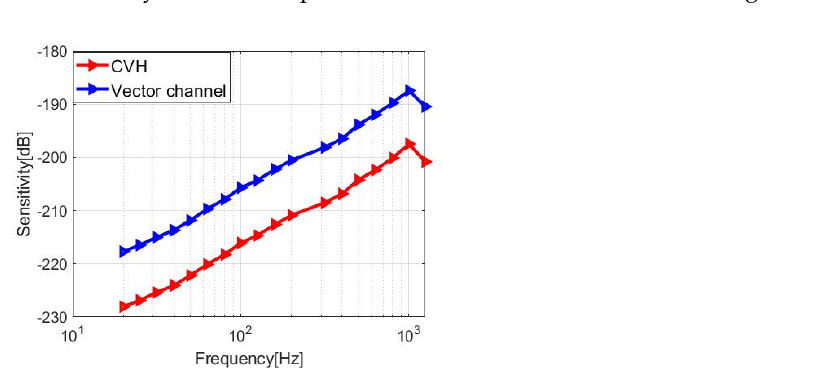
Figure 16. The composite hydrophone test system.